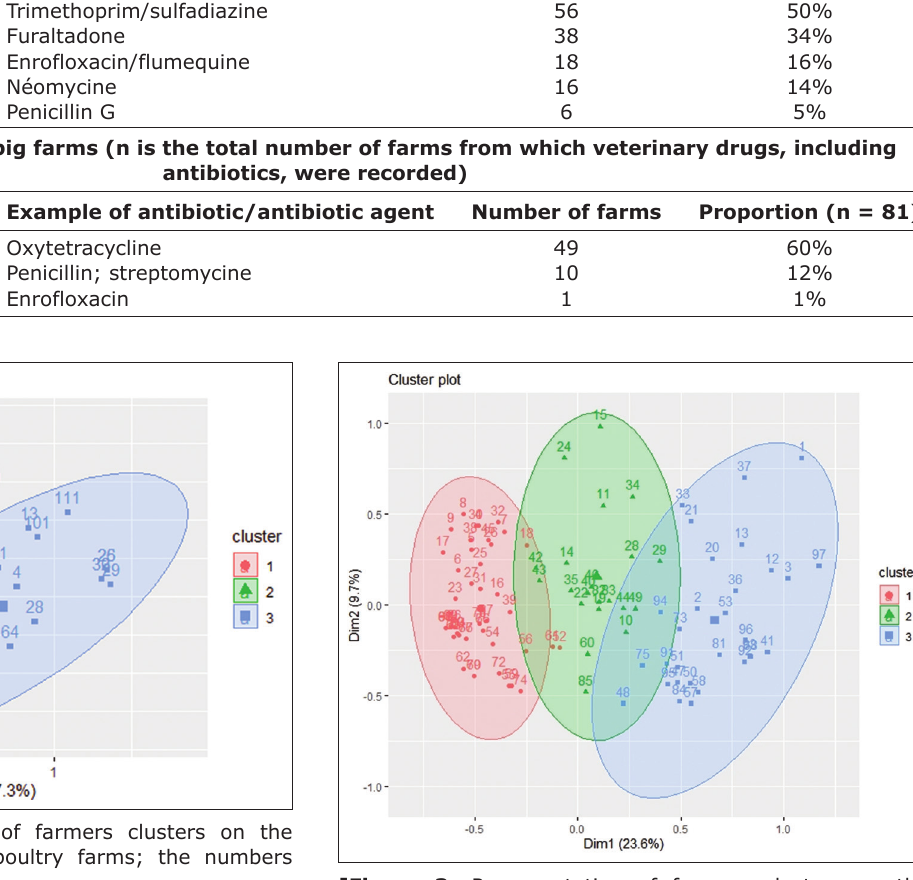
factorial axes 1 and 2 in pig farms; the numbers correspond to the